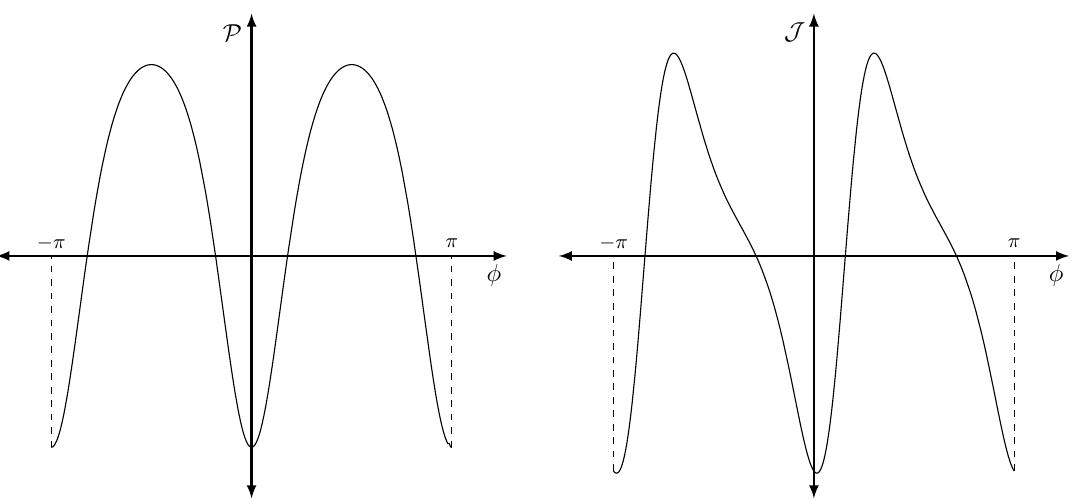
Figure 2 . Pro(cid:12)les of P (cnoidal wave in (4.64)) and J in (4.66) for a (cid:12)xed generic value of A , (cid:11) , m and t